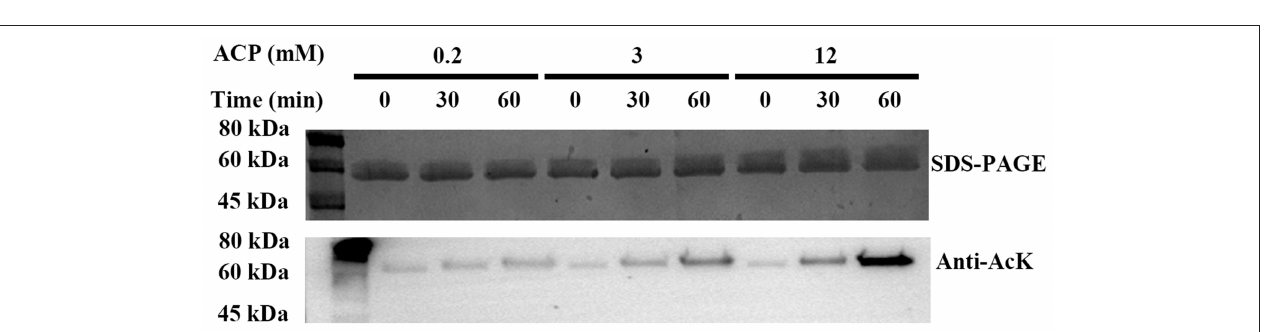
deacetylation of these two sites has an important role in protease activity